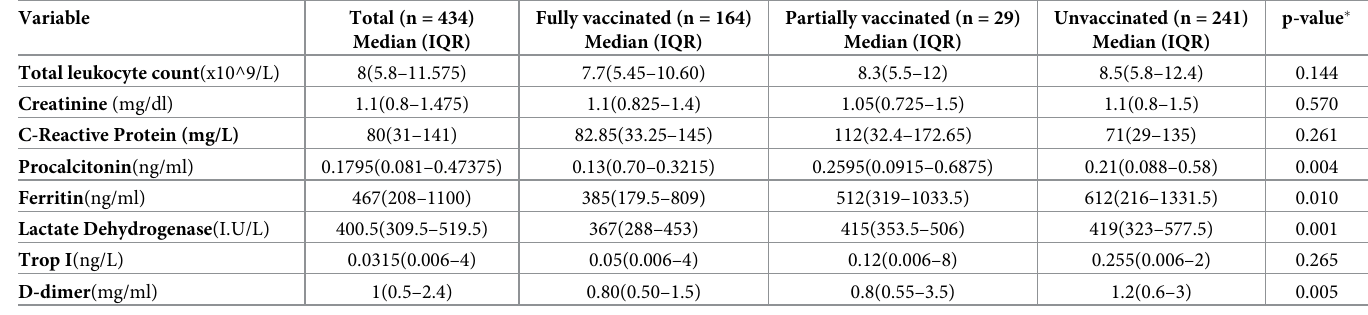
Table 3. Baseline laboratory parameters of patients with COVID-19 infection in correlation to vaccination status.